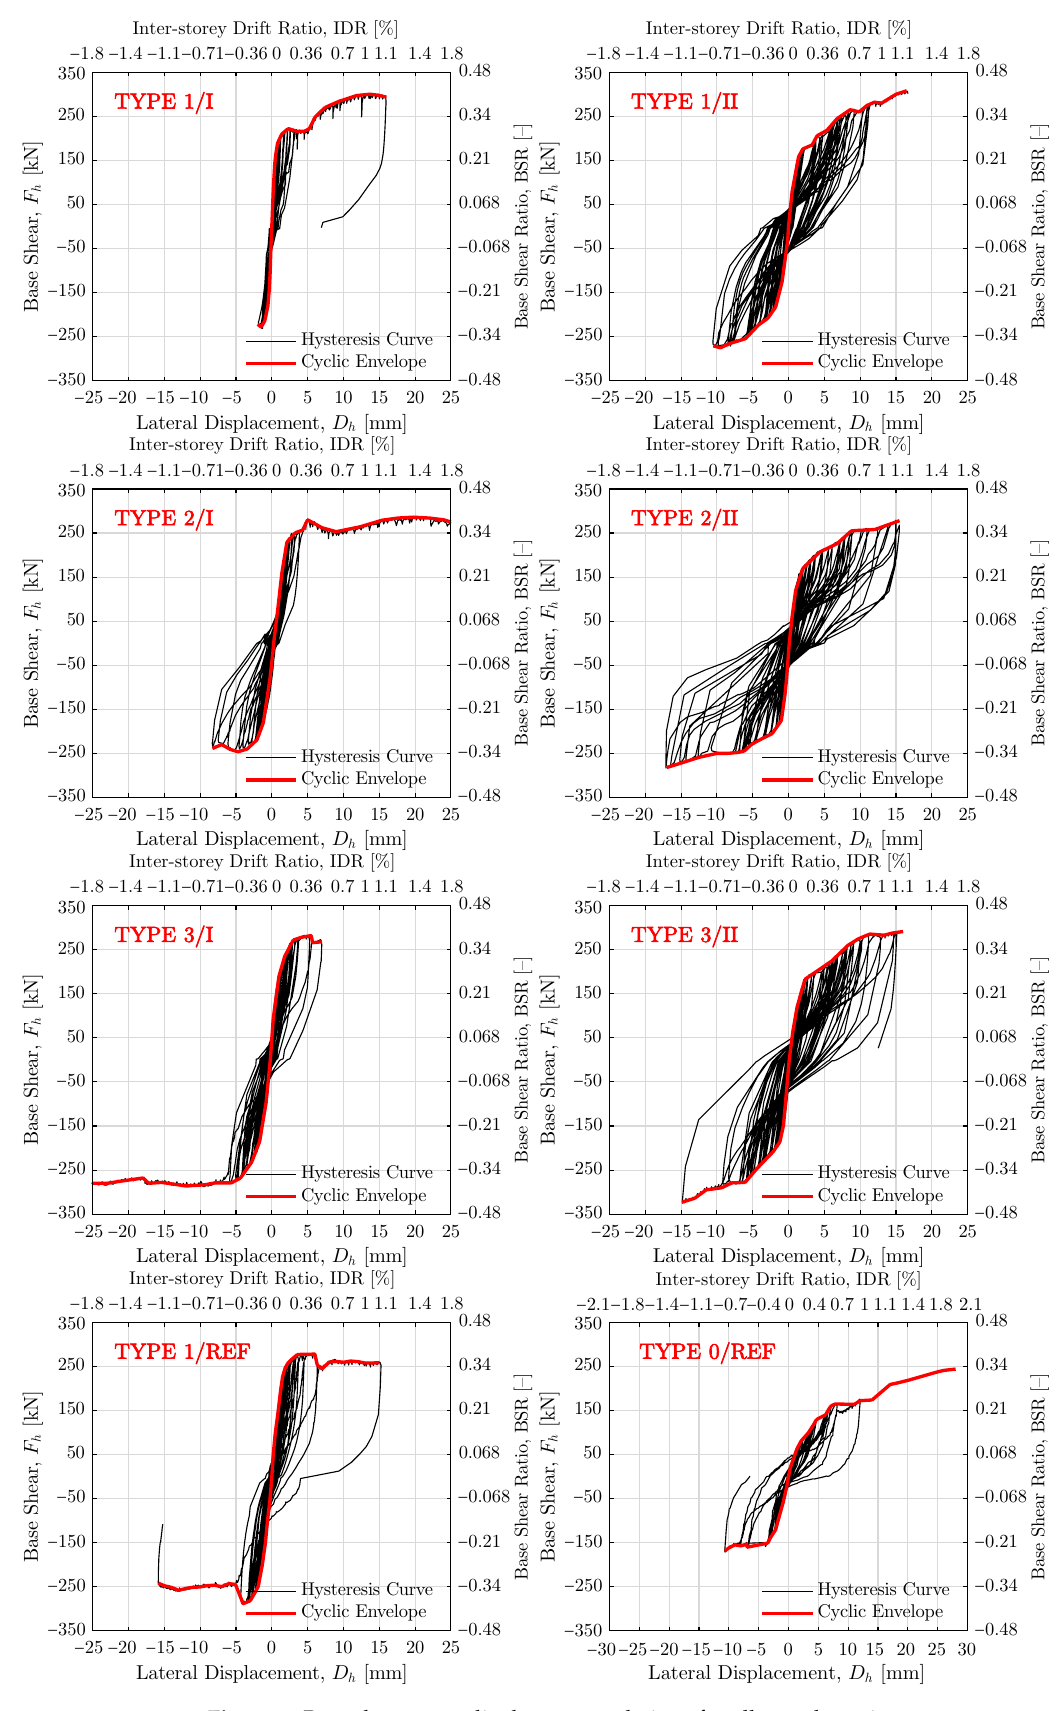
Figure 8. Base shear—top displacement relations for all tested